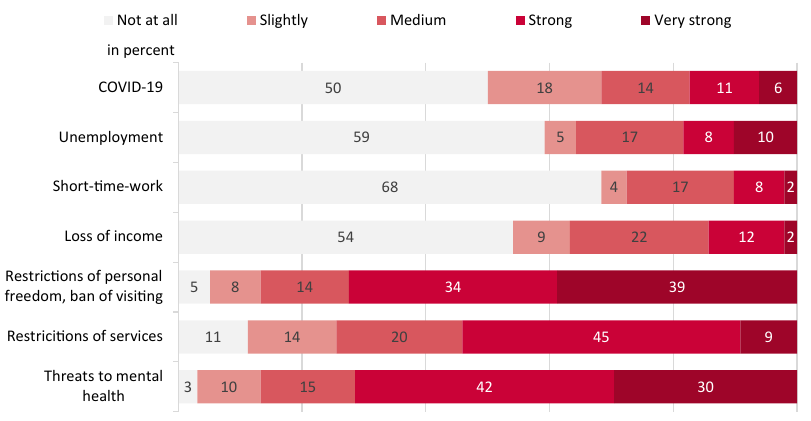
Figure 4: Affectedness of clients of social service CSOs in all fields (n =